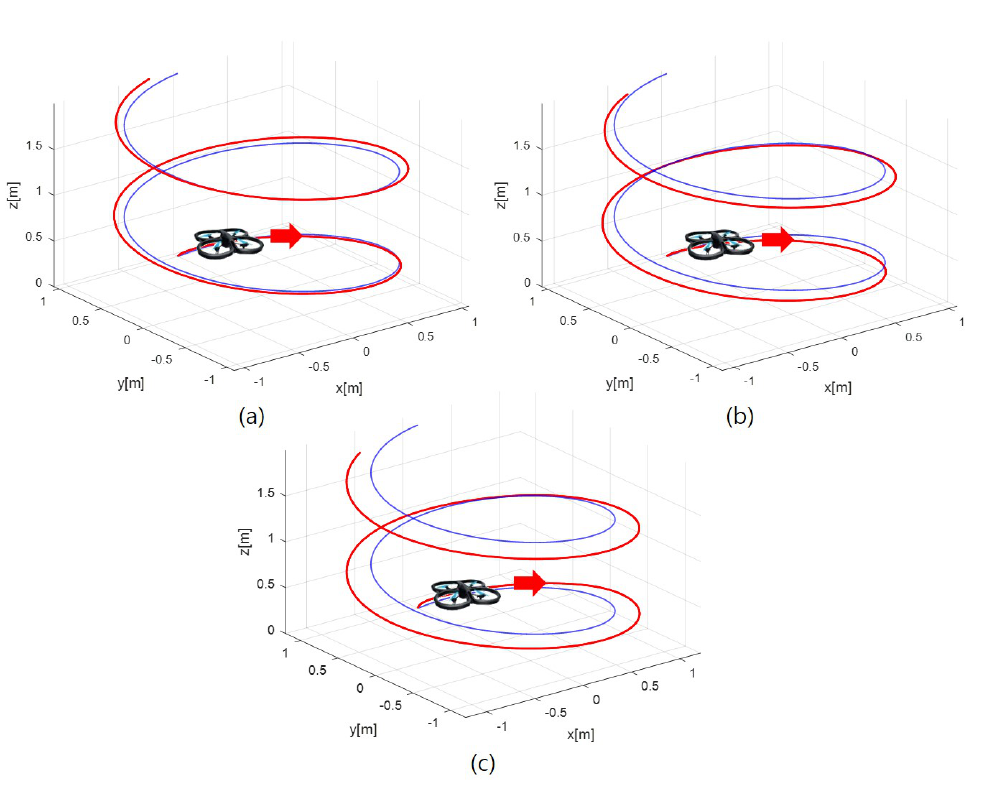
Figure 11. Circular trajectory tracking control results: ( a ) Inverse optimal control; ( b ) LQR control; ( c ) PD control.